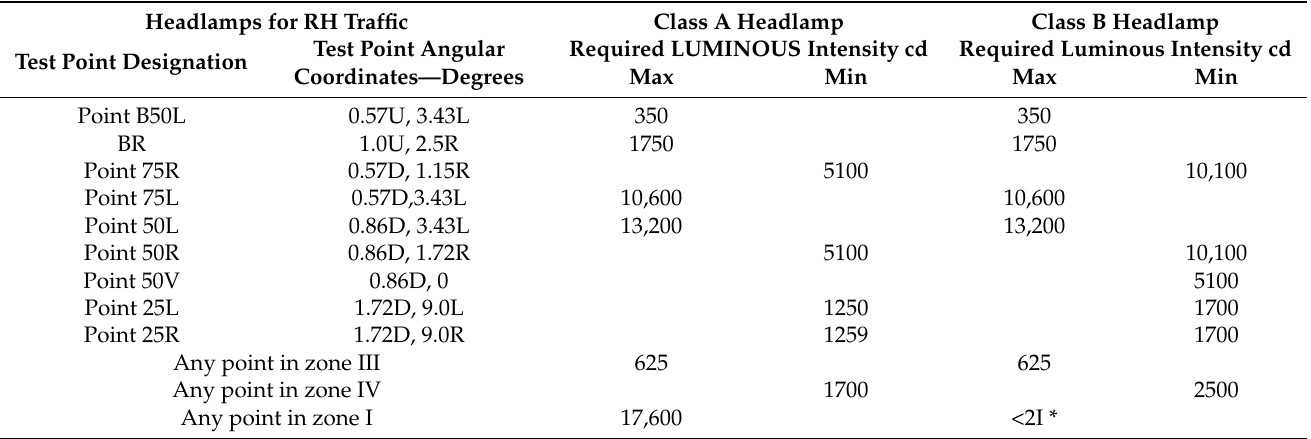
Table 1. Luminous intensities at the test points and zones required for the right-hand traffic passing beam.